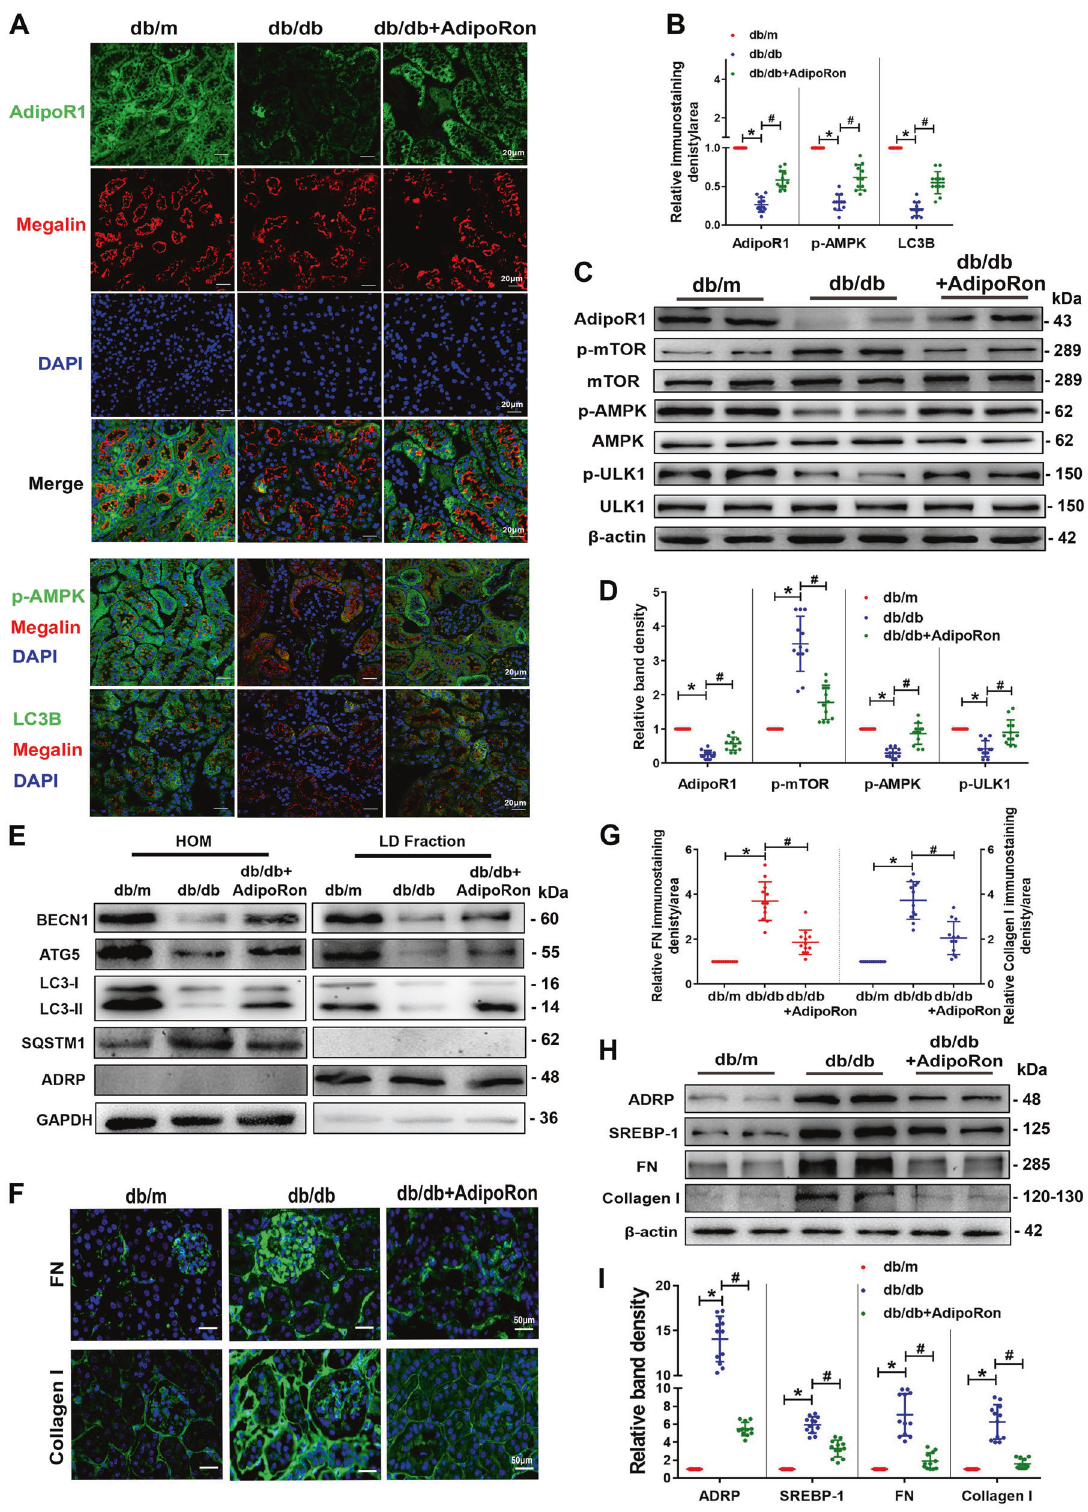
Fig. 4 AdipoRon increased lipophagy, activated AdipoR1/AMPK pathway and alleviated fi brosis in the kidney of db/db mice. Representative IF images of AdipoR1, p-AMPK, and LC3B in the kidney tissues (magni fi cation, ×400) ( A ). Semiquanti fi cation of the IF analysis of AdipoR1, p-AMPK and LC3B ( B ). WB analysis and quanti fi cation of AdipoR1, p-mTOR, p-AMPK and p-ULK1 expression in the kidneys ( C , D ). WB analysis of the indicated molecules using homogenates (HOM) and isolated LD fractions from the kidneys ( E ). Representative IF images and semiquanti fi cation of FN and Collagen I in the kidneys ( F , G ). WB analysis and quanti fi cation of the ADRP, SREBP-1, FN and Collagen I levels ( H , I ). Values are the mean ± SD; * p < 0.05 versus control, # p < 0.05 versus db/db group. n = 12.